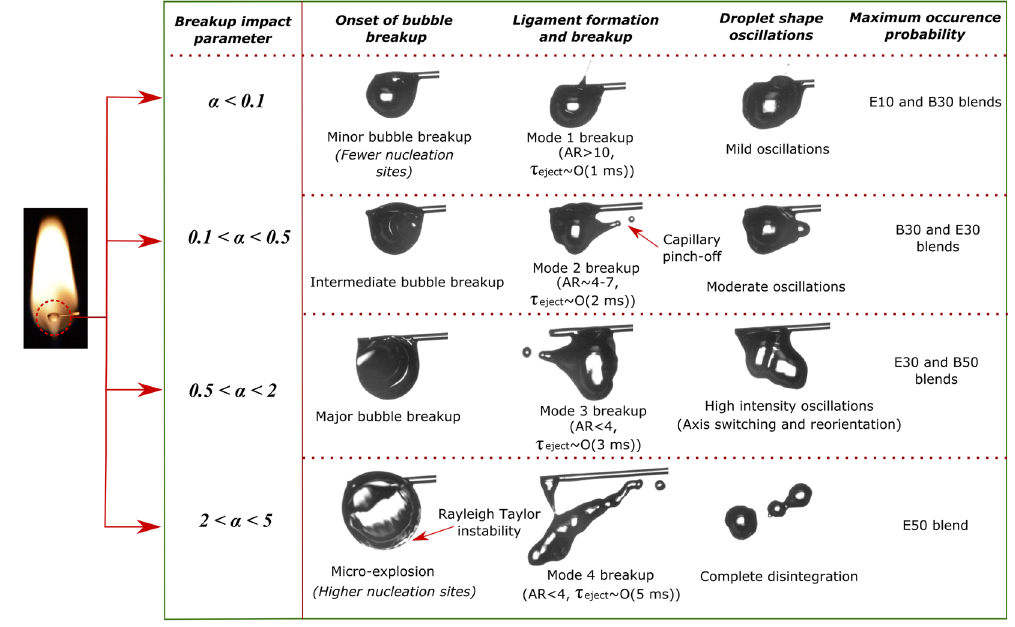
Figure 13. Schematic representing the summary of